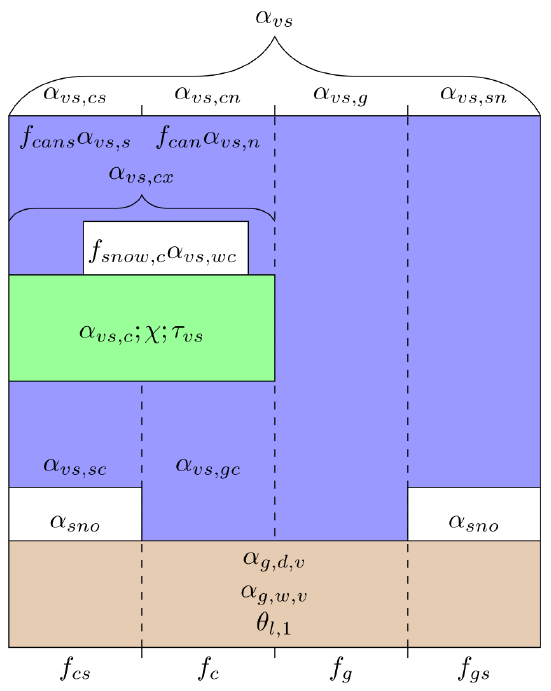
Figure A25. Contributions from the bare ground (brown), canopy (green), and snow (white) to the total visible albedo of the land sur- face. All variables are defined in the Appendix.